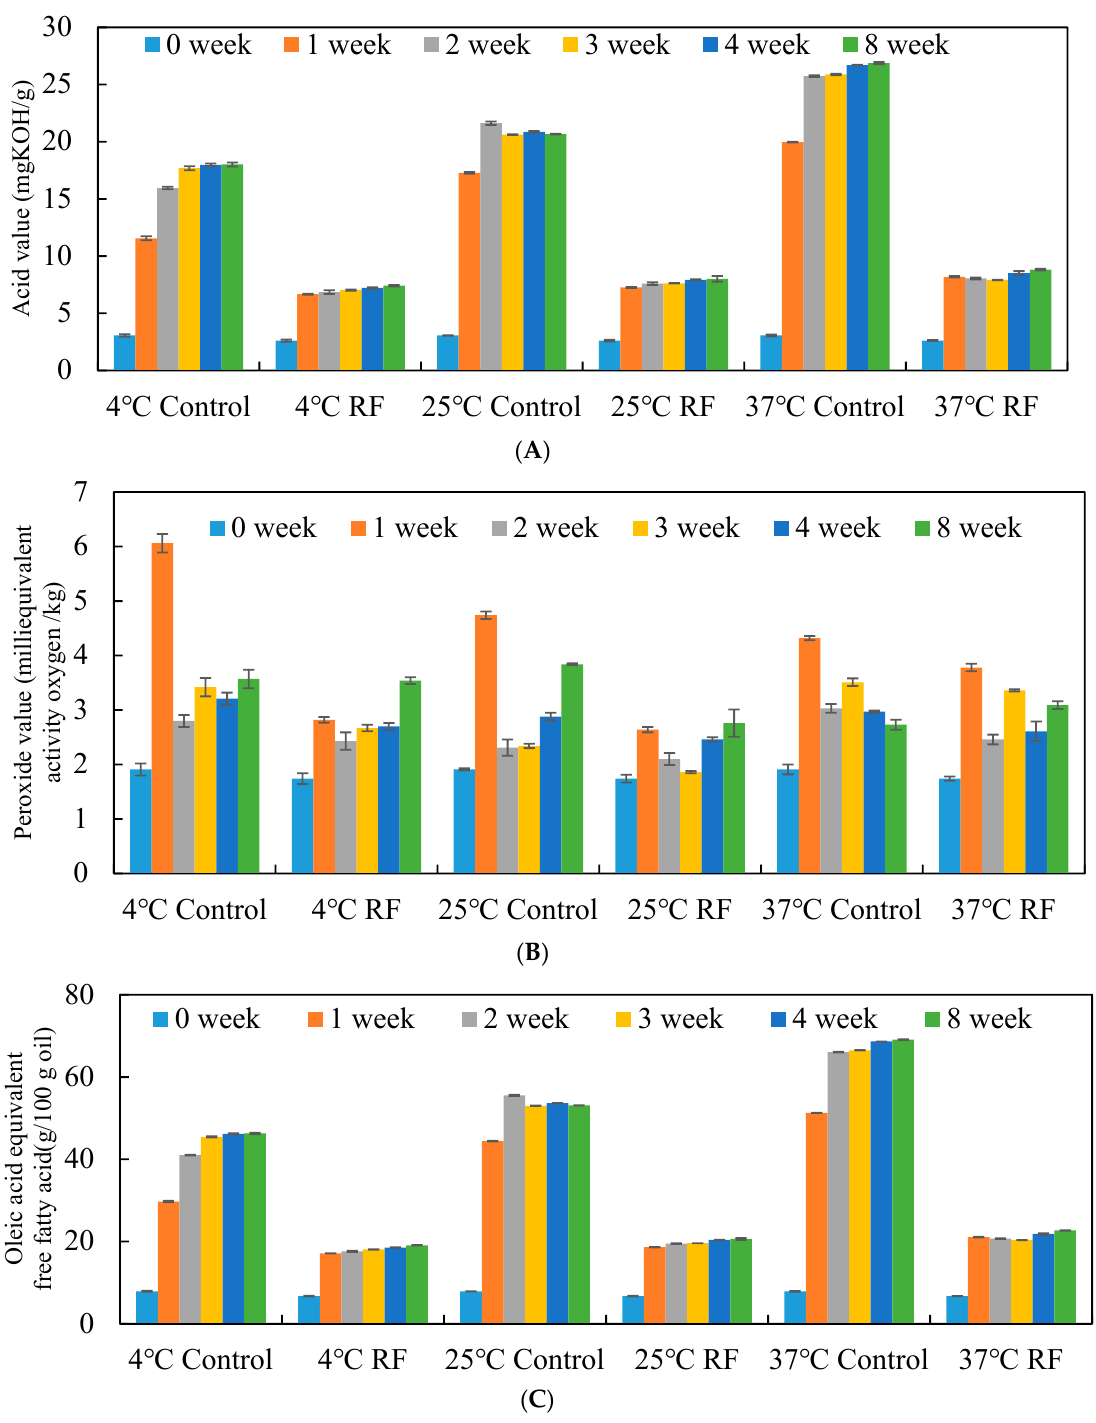
Figure 3. ( A ) The acid value, ( B ) free fatty acid content and ( C ) peroxide value change of RF-treated rice bran during different temperatures and storage periods. Data are expressed as the mean ± SD ( n = 4).